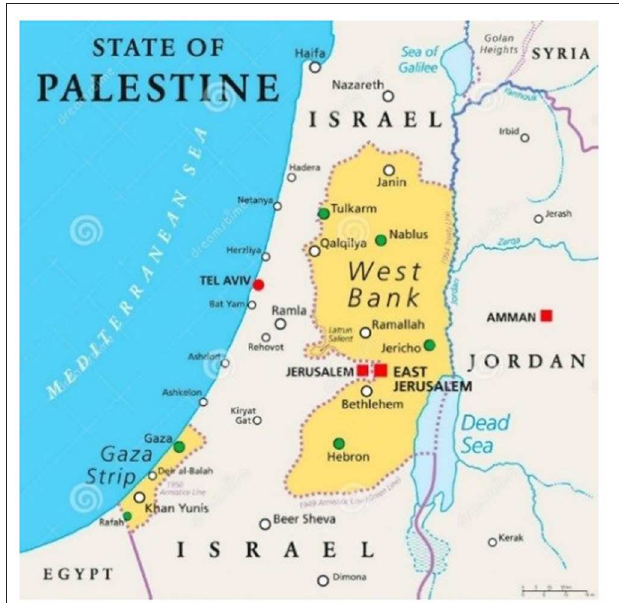
FIGURE 1 | The cities concerned in the Palestine State (circled green ). [source: https://www.dreamstime.com/stock-illustration-state-palestine- political-map-designated-capital-east-jerusalem-claiming-west-bank-gaza- strip-borders-image74413499].